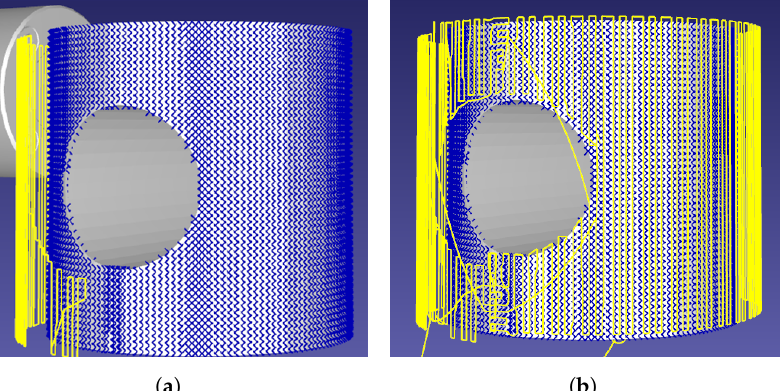
Figure 5. The scan initially misses sections of the pipe due to the shape’s cross-sectional hole.The missed points are picked up at the end of the scan as there is memory of surface-positions to check. Points found are marked in blue, the robotic path traced in yellow. ( a ) Initial scan-pass. ( b ) End-of-scan.